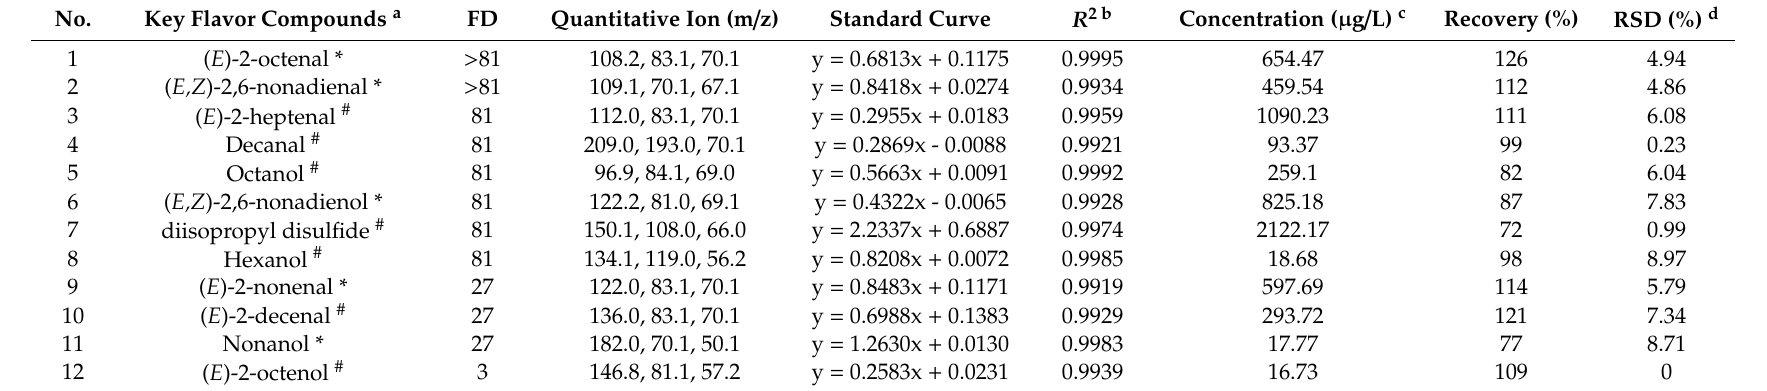
Table 3. Standard curve and concentrations of aroma-active and key o ff -flavor compounds in